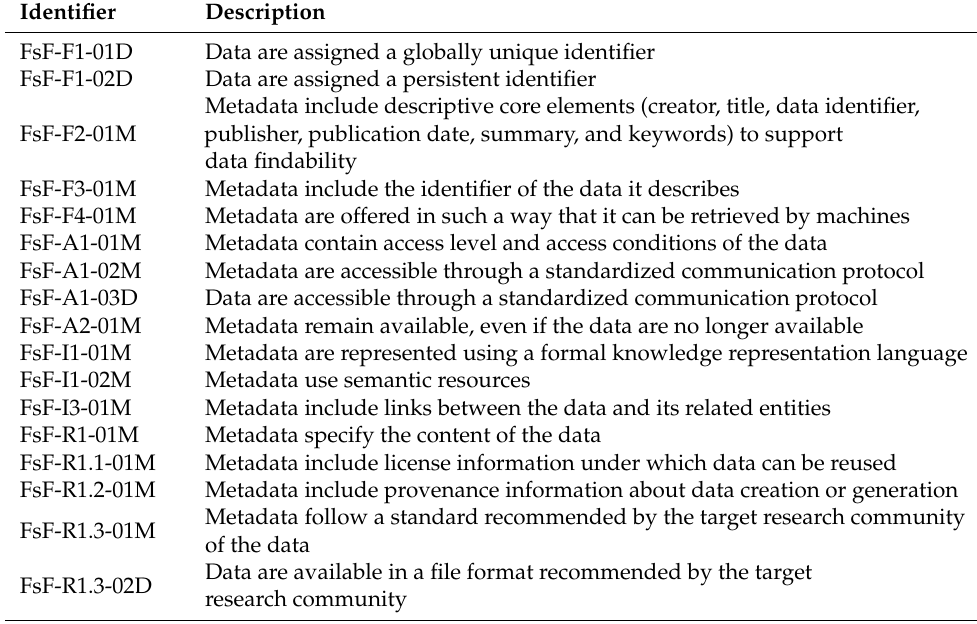
Table 1. FAIRsFAIR metrics